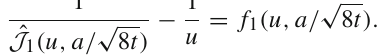
The continuum curve is at most two standard deviations away √ 8 t / a ≈ 1 . 6), and the two from the coarser lattice data ( √ 8 t / a ≈ 3 . 2 , 4 . 8 show no significant finest lattices with deviation from the continuum